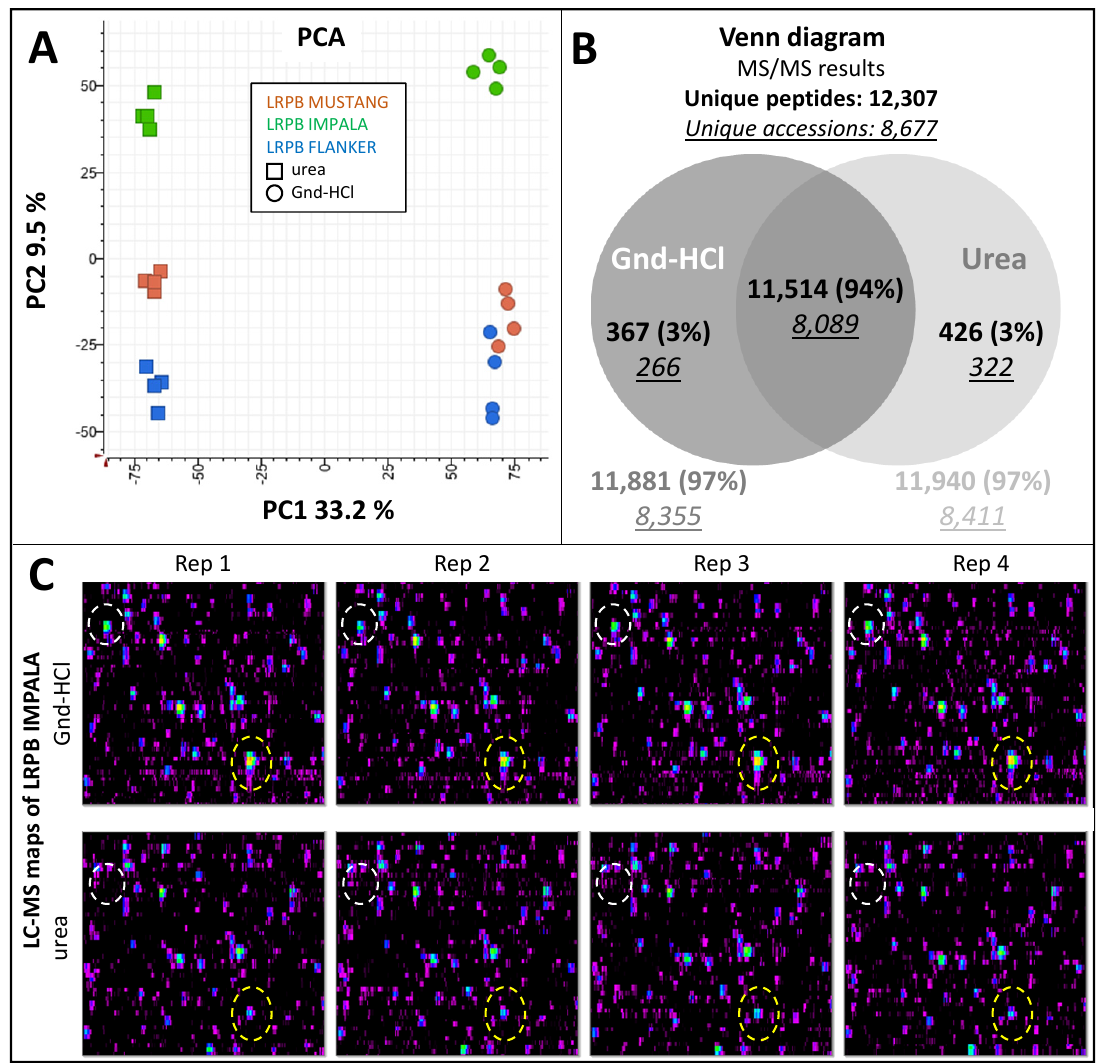
Figure 3. Testing extraction buffers. Twenty milligrams ( ± 0.2 mg) from three wheat cultivars (LRPB Mustang, LRPB Impala, LRPB Flanker) was weighed in four replicates, extracted using 0.5 mL Gnd-HCl or urea buffer. Protein extracts were assayed to obtain protein concentrations and 100 µ g proteins were digested using trypsin/Lys-C protease mixture. LC–MS/MS data were acquired using LC method 1. ( A ) PC1 vs. PC2 plot based on LC–MS quantitative data; ( B ) Venn diagram of the identified unique peptides and accessions for each extraction buffer; ( C ) zoomed-in section of LC–MS maps at 28–36 min and 950–990 m / z of LRPB Impala cultivar for both extraction buffers tested across four technical replicates; cluster qualitative and quantitative differences are highlighted in